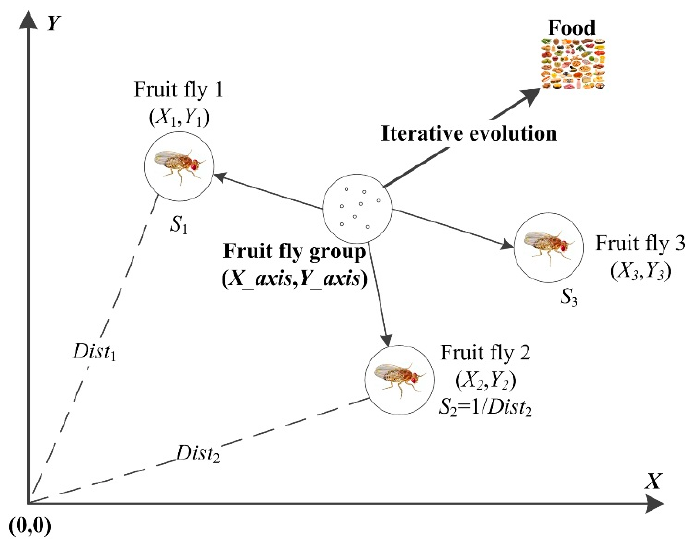
Figure 1. Process of foraging behavior for fruit fly group.